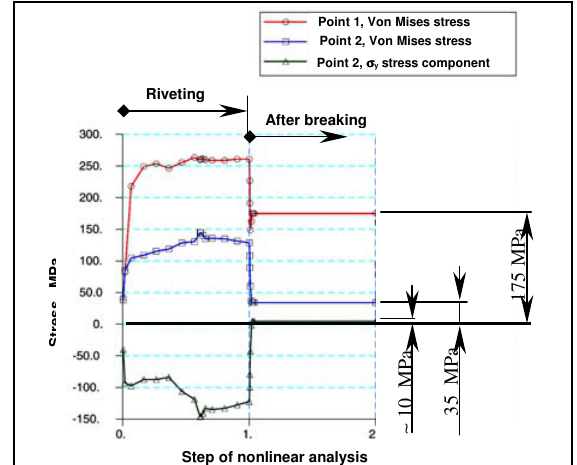
Fig 9. Values of stresses for control points No 1 and 2 during the riveting